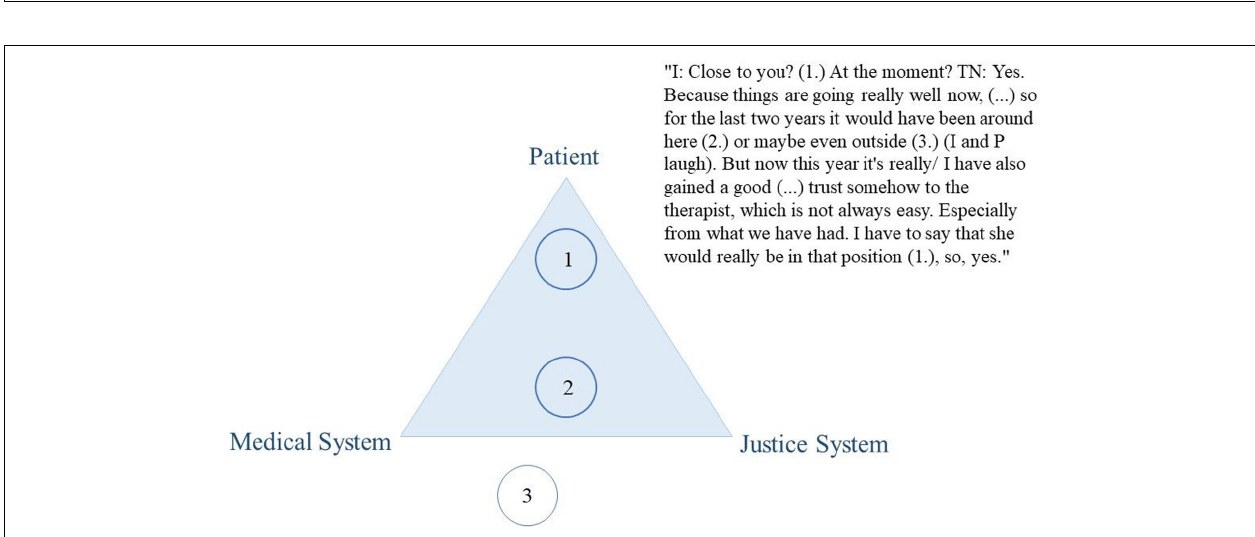
FIGURE 3 | Citation of participant D439.